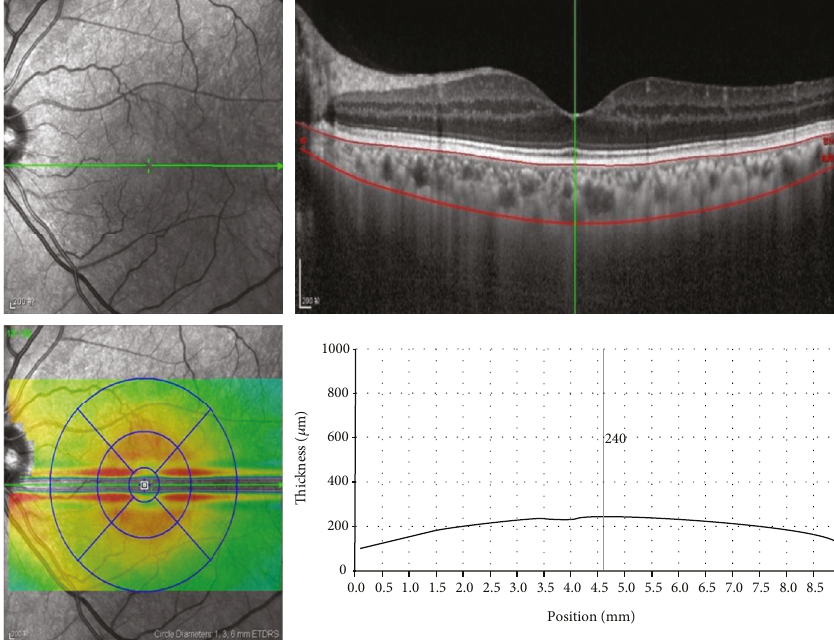
Figure 4: Subfoveal choroidal thickness (SFChT) measurements. For SFChT measurements, we manually moved the automatically segmented internal limiting membrane line to the choroidoscleral junction. Once we changed the automatically segmented line and set a vertical line perpendicular to the center of the fovea, the SFChT was automatically Table 1. The results indicate there were no signi fi cant di ff erences among the four groups in terms of age, gender, body mass index, or the prevalence of hypertension and hyperlipidemia. Thus, we have ignored their in fl uence on the fi nal analyses.